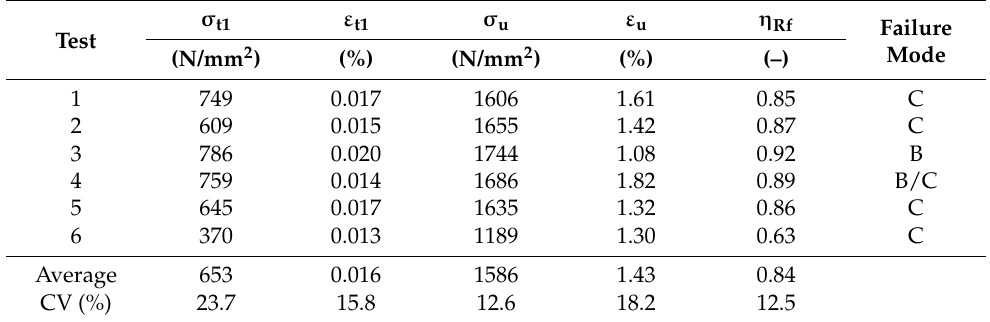
Table 6. B-NHL test results.